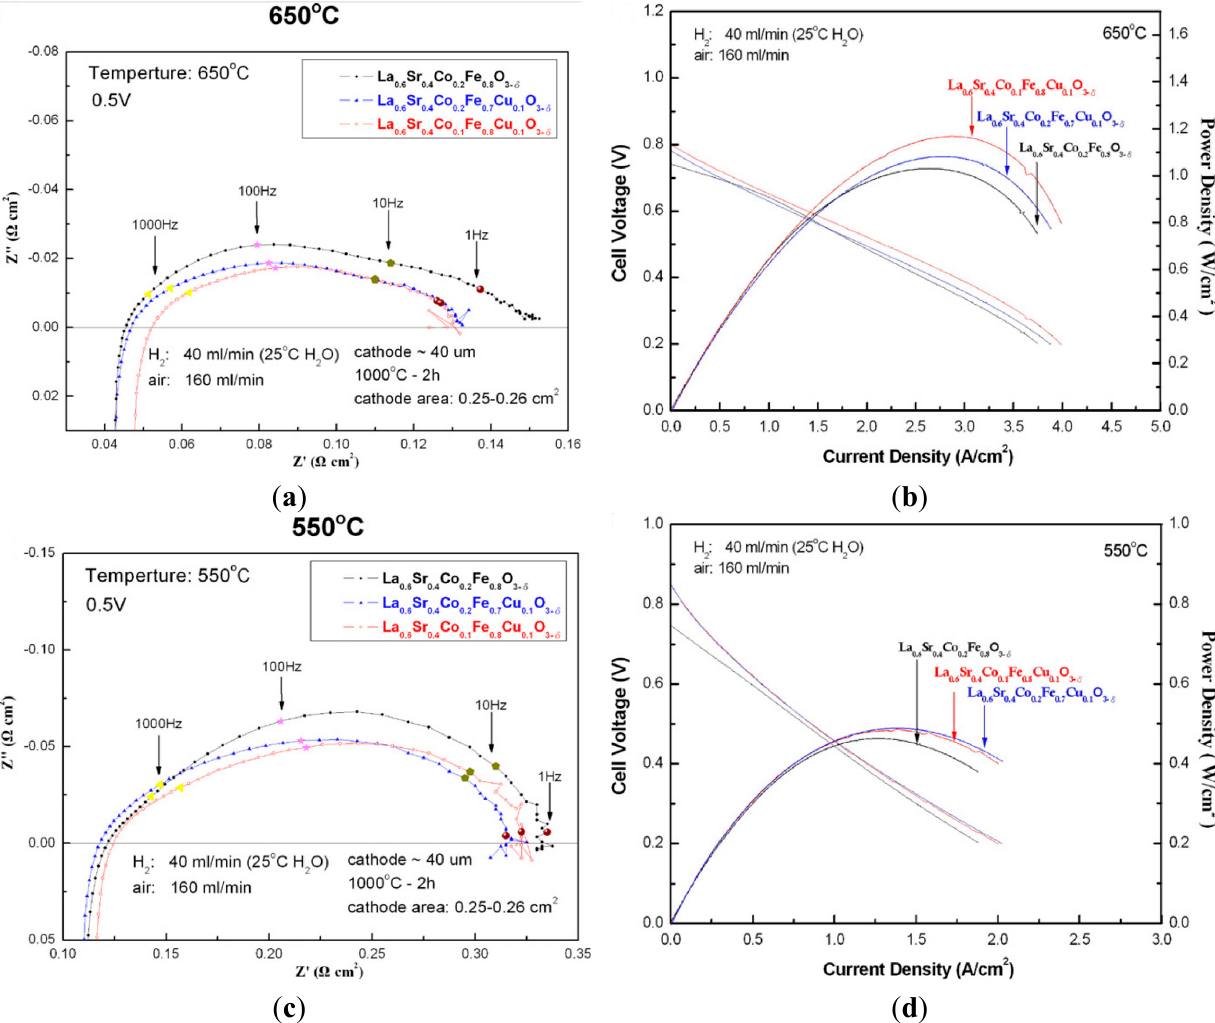
Figure 7. Nyquist plots of electrochemical impedance spectra of the single cells containing La 0.6 Sr 0.4 Co 0.2 Fe 0.8 O 3−δ , La 0.6 Sr 0.4 Co 0.2 Fe 0.7 Cu 0.1 O 3−δ and La 0.6 Sr 0.4 Co 0.1 Fe 0.8 Cu 0.1 O 3−δ cathodes measured at ( a ) 650 °C and ( c ) 550 °C and I–V curves and the corresponding power densities of the anode supported single cells with various cathodes measured at ( b ) 650 °C and ( d ) 550 °C. (Reprinted with permission from [42], 2011,